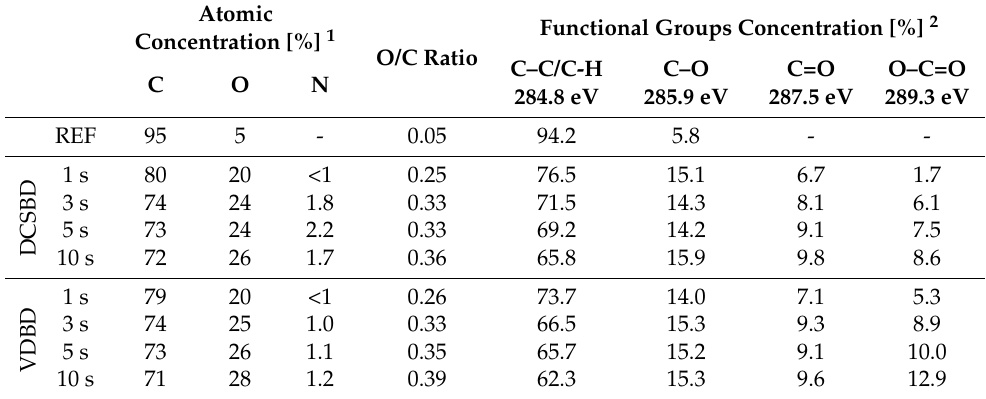
Table 1. The atomic concentration and relative area of C1s chemical bonds of the BOPP surface analyzed by XPS measurement after treatment by DCSBD and VDBD plasma